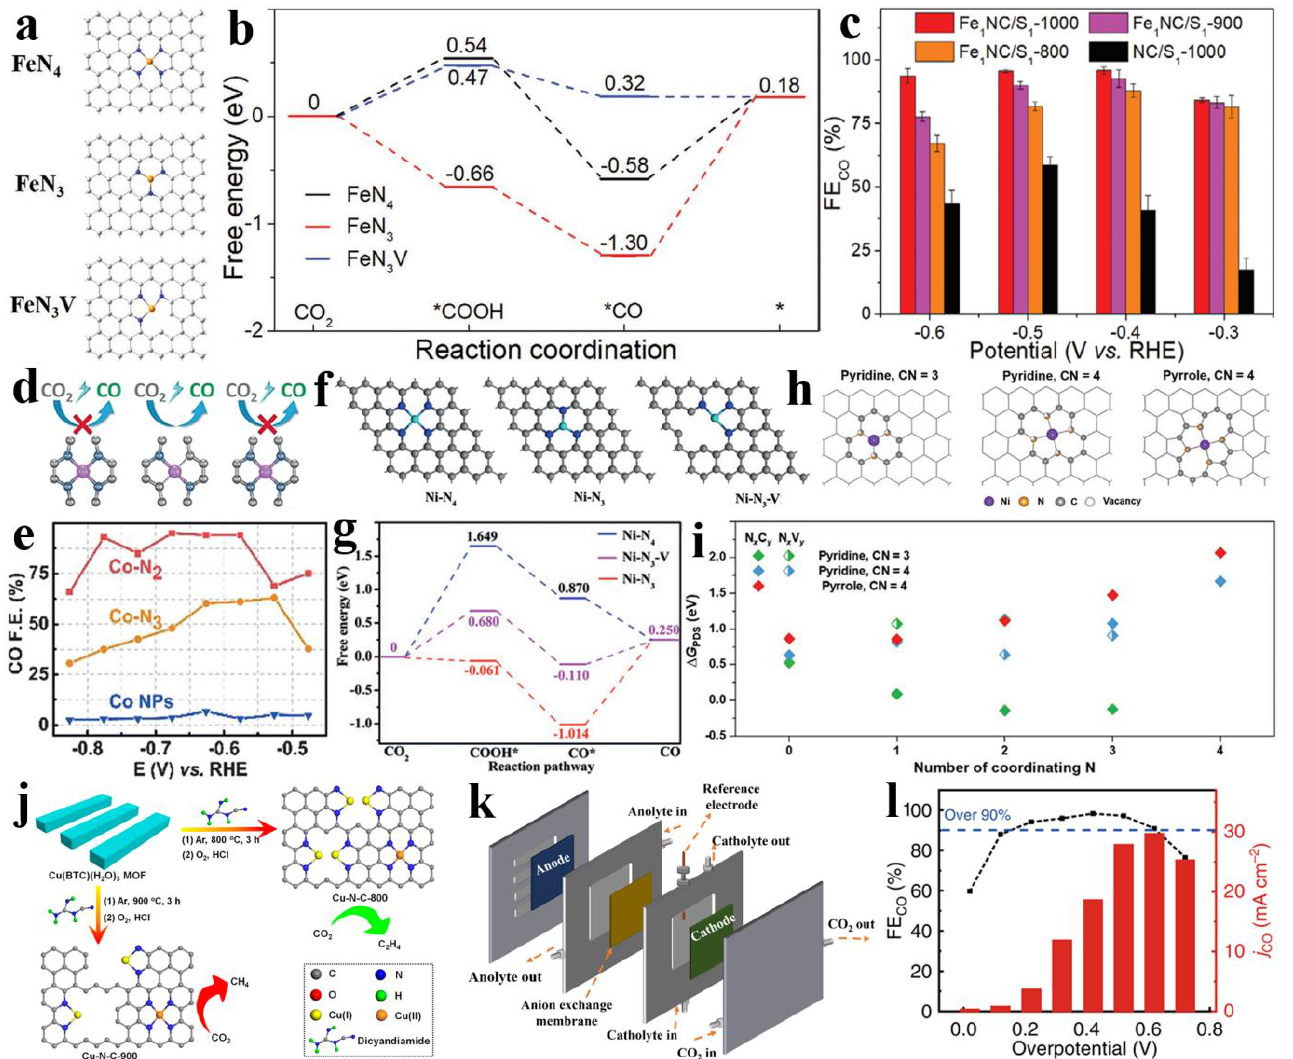
Figure 4. ( a ) The optimized atomic structures of FeN 4 , FeN 3 , and FeN 3 V. ( b ) The calculated free- energy diagrams. ( c ) FE CO . Reprinted with permission from ref. [66]. Copyright: (2020) WILEY-VCH Verlag GmbH & Co. KGaA, Weinheim. ( d ) Atomic structures of CoN 4 and CoN 2 on graphene. ( e ) FE CO . Reprinted with permission from ref. [96]. Copyright: (2018) Wiley-VCH Verlag GmbH & Co. KGaA, Weinheim. ( f ) The optimized atomic structures of Ni SACs. ( g ) Calculated free-energy dia- gram. Reprinted with permission from ref. [71]. Copyright: (2020) Wiley-VCH Verlag GmbH & Co. KGaA, Weinheim. ( h ) Different coordination structures of NiNG SACs. ( i ) The calculated free en- ergy change at potential determining step (PDS; ΔGPDS). Reprinted with permission from ref. [72]. Copyright: (2021) Wiley-VCH GmbH. ( j ) Schematic of preparation of the Cu-N-C-T catalysts. Re-